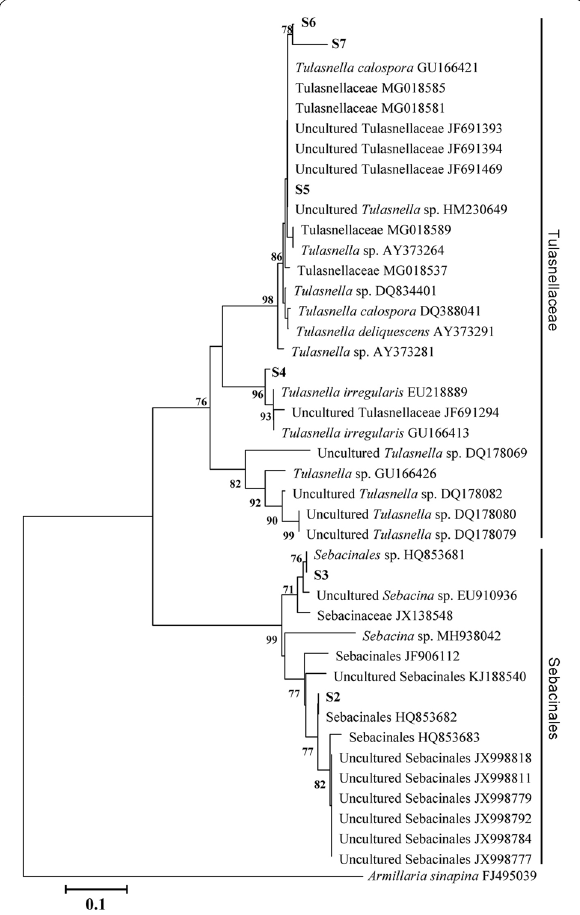
Fig. 1 Phylogenetic relationships of the fungal strains used in this study based on neighbor‑joining analysis of internal transcribed spacer rDNA sequences of Tulasnellaceae and Sebacinales available in GenBank. Bootstrap values (calculated from 1000 re‑samplings) > 70% are shown at branches. Armillaria sinapina was the